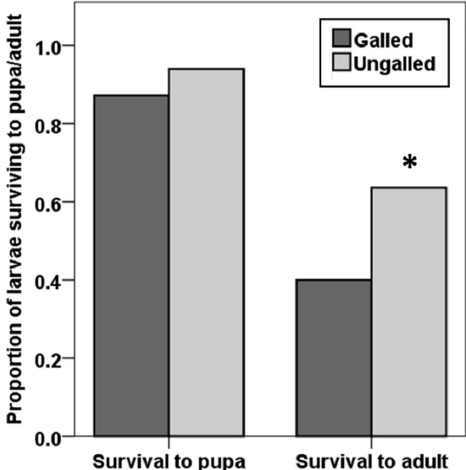
Figure 2. Proportion of N. conspurcatalis larvae, feeding on galled or ungalled L. mocrophyllum sprigs, surviving to pupation and adulthood ( n = 110). Asterisks indicate significant differences.